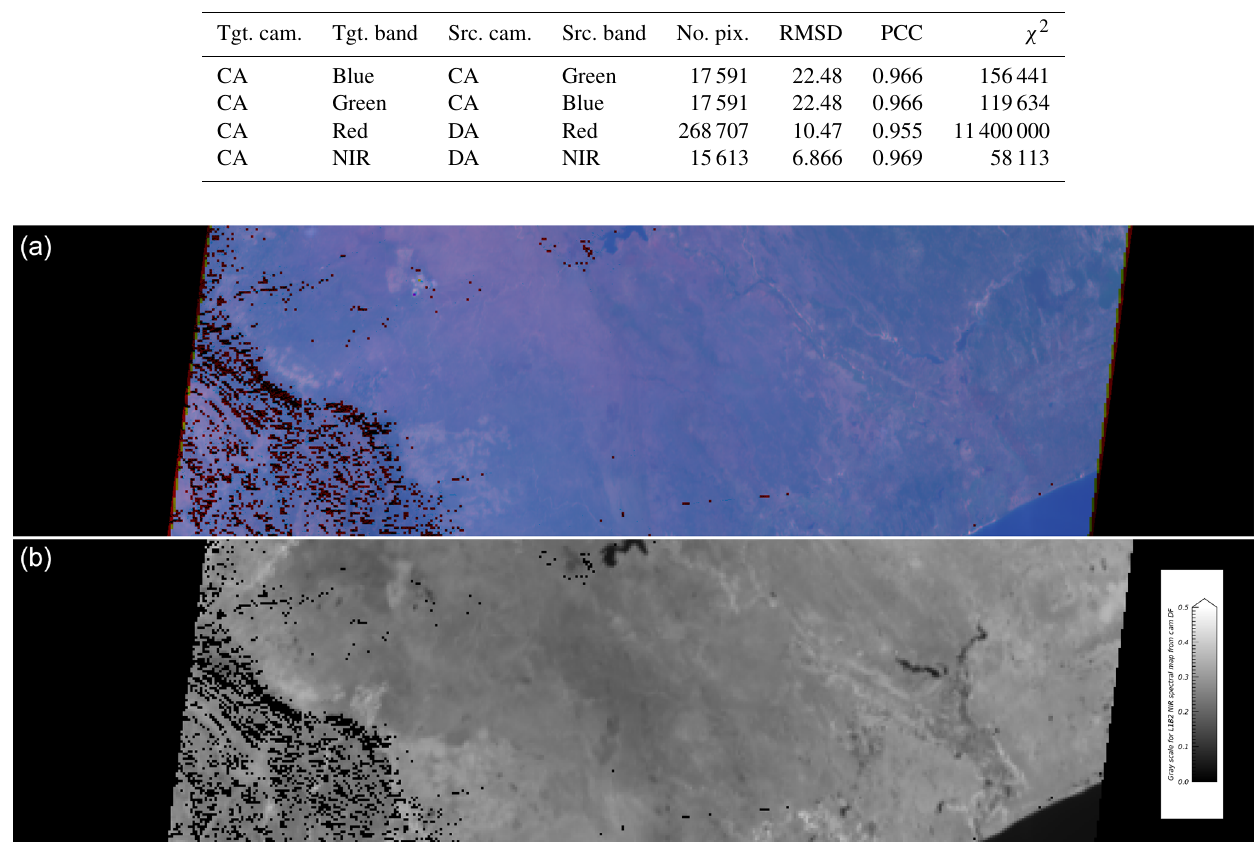
Figure 9. (a) RGB composite map of the red, green and blue spectral bands for the L1B2 terrain-projected G LOBAL M ODE bidirectional reflectance factor data file for the same DF camera case exhibited in Fig. 2. (b) Map of the NIR spectral band for the same DF camera. All missing values in the original data files have been replaced by estimates as described in the text. The linear dimensions are the same as in Fig. 1, and all three visible spectral channels are stretched from 0.0 to 0.35 for the purpose of generating the color image; the gray scale used to stretch the NIR data for the bottom frame assigns black to reflectance values of 0.0 and white to values of 0.50 or